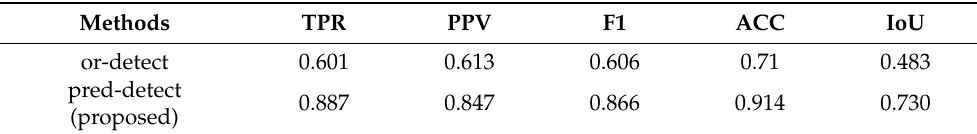
Figure 10. Examples of segmentation results before and after image prediction. ( a – d ) From left to right, the original input images, results with original input images, GT images, results with GT images, images predicted by the proposed method, and results with predicted images. Table 13. Comparisons of segmentation accuracies with original images (or-detect) and with images predicted by the proposed method (pred-detect).